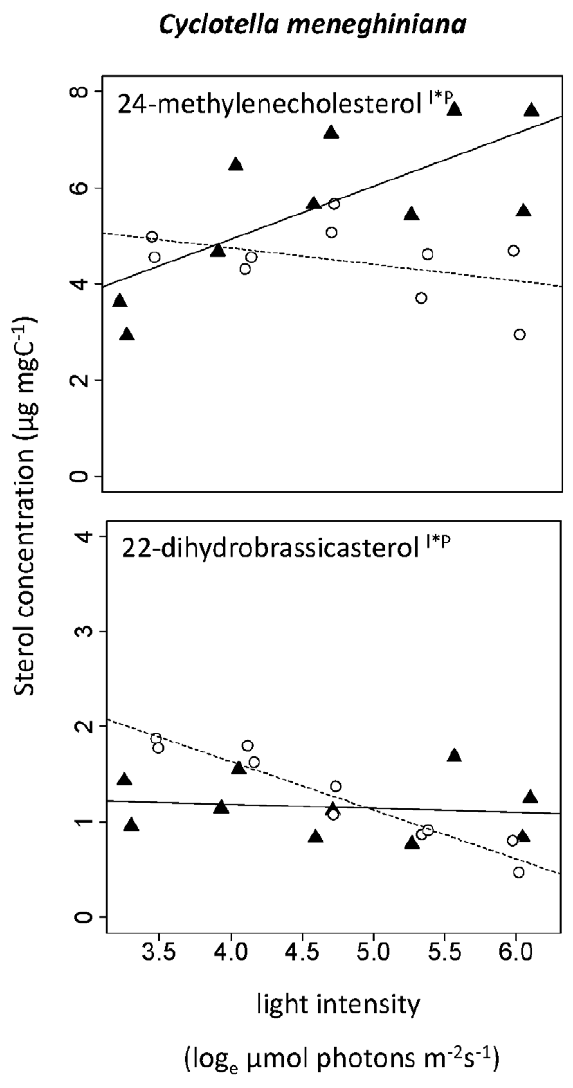
Figure 4. Change in sterol content with light intensity in Cyclotella meneghiniana . ( m , straight line) High-P treatments. ( # , dashed line) Low-P treatments. Superscripts indicate statistically significant effects of light intensity (l), phosphorus supply (P), or interaction of these two factors (l*P). A regression line was added if one of the effects was